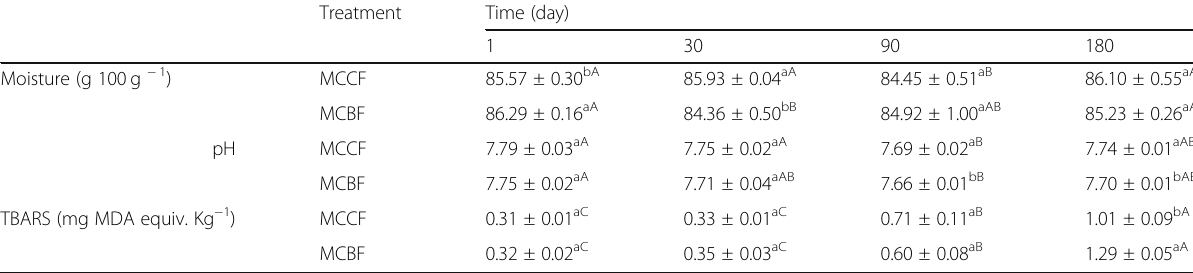
Table 3 Moisture content, pH and TBARS of crawfish minced meat during frozen storage Treatment